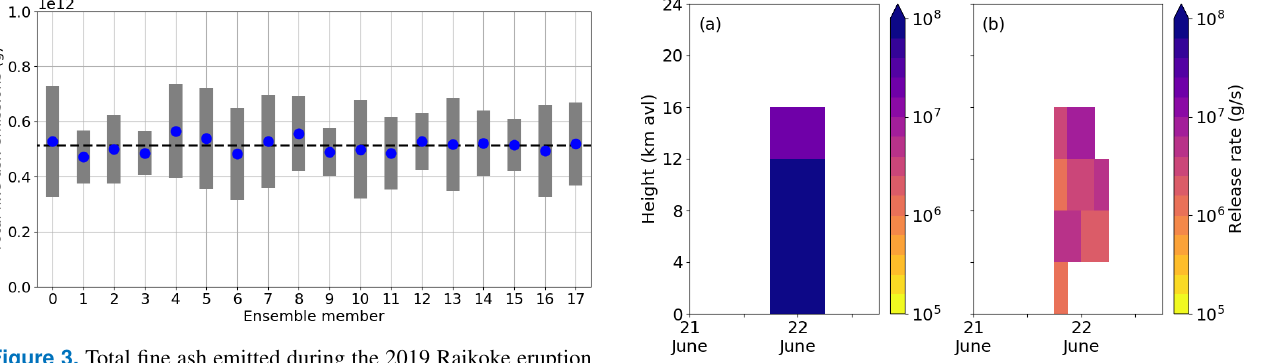
Figure 4. (a) Prior (b) ensemble mean posterior time–height emis- sion profile (gs − 1 ) determined by InTEM for the Raikoke eruption. Note the log scale used for the release